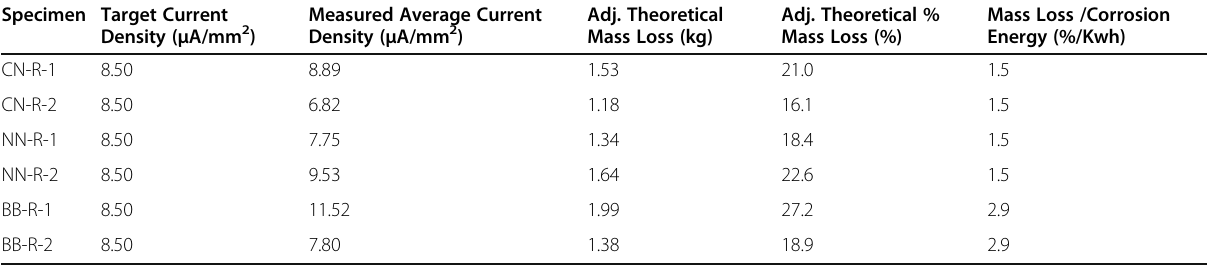
Table 3 Summary of corrosion analysis Specimen Target Current Density ( μ A/mm 2